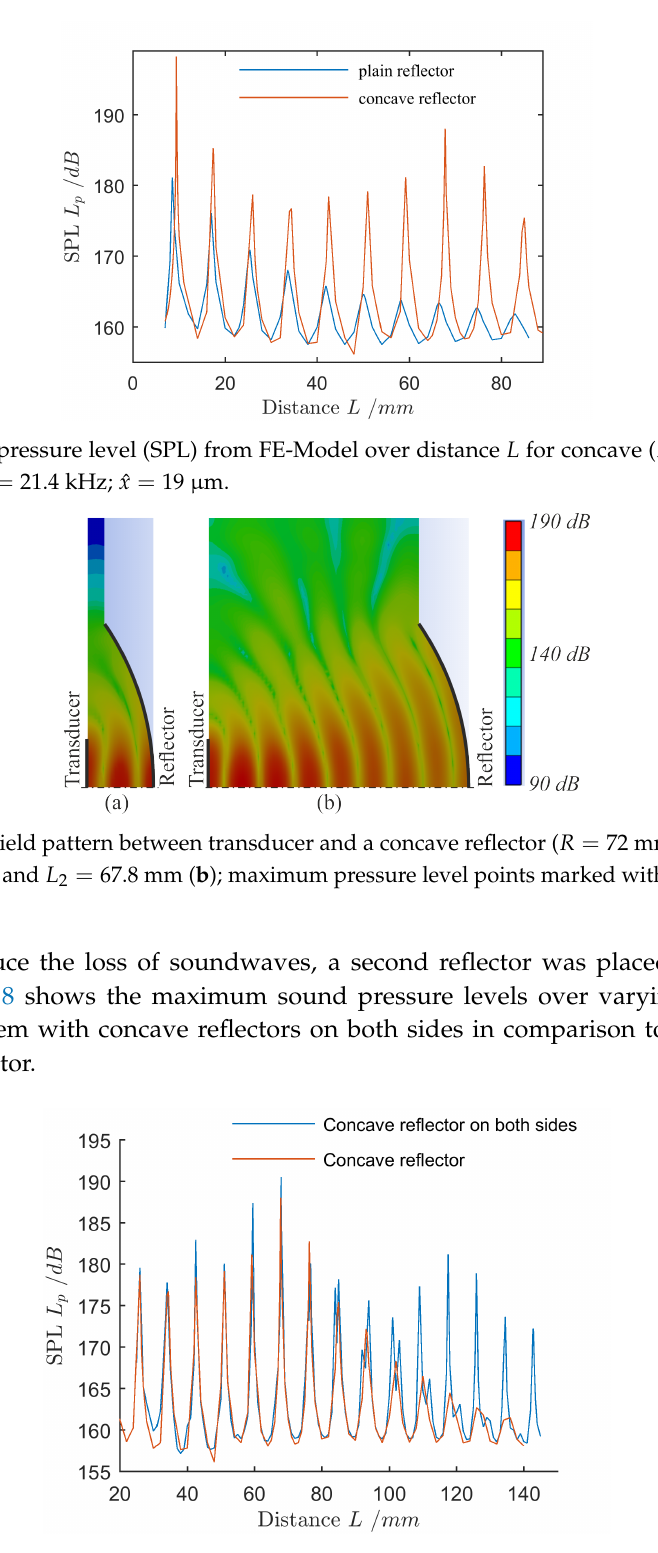
Figure 8. Sound pressure level (SPL) from FE-Model over distance L for concave reflector on both sides and plain reflector; R = 72 mm; f = 21.4 kHz; ˆ x = 19 µ